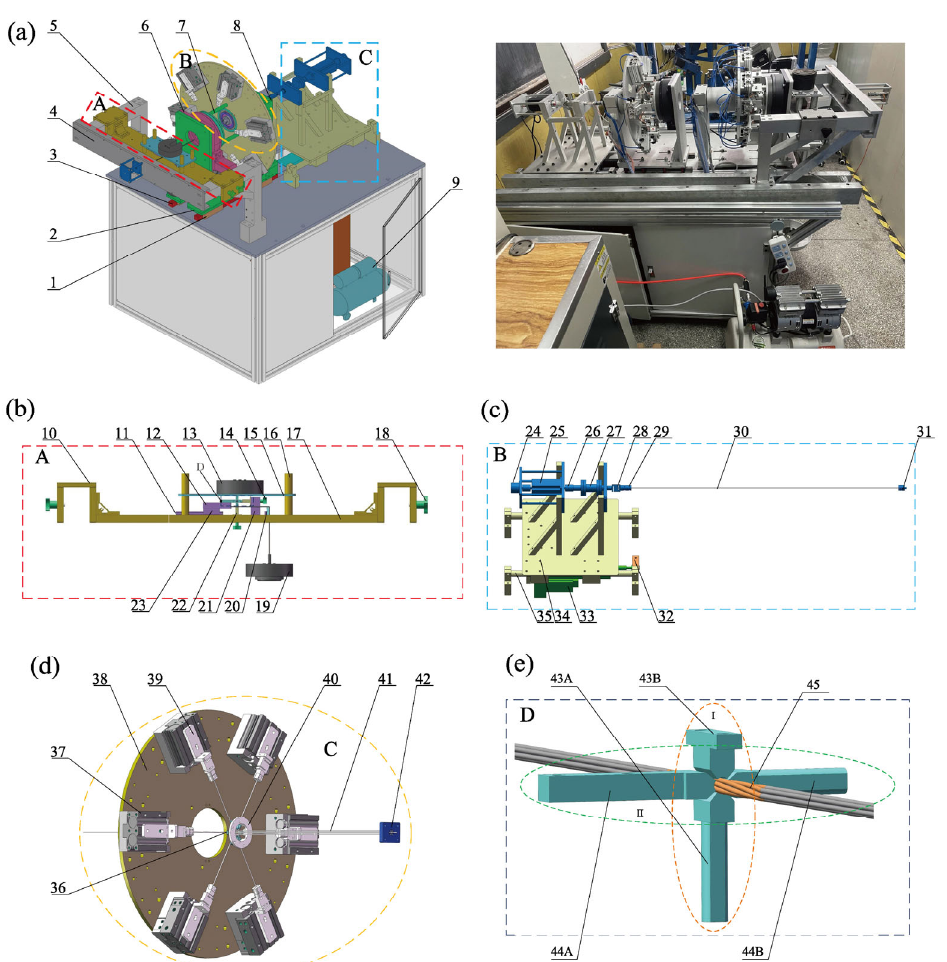
Fig. 2 Structural drawings for the fretting and friction test rig. (a) Whole structure of the test rig, (b) lateral loading device, (c) central wire tension and torsion structure, (d) twisted structure, and (e) circumferential loading structure of rope strands. Note: 1-Slider, 2-Baseplate, 3-Sliding rail, 4-Long baseplate, 5-Cantilever, 6-Electric indexing board, 7-Joint lever, 8-Pneumatic stents, 9-Air pump, 10-U-sheet, 11-Small slider, 12-Continuous blocks, 13-Upper loading block, 14-Ejection knob, 15-Load baseplate, 16-Guide bar, 17-Horizontal loading baseplate, 18-Clamping knob, 19-Lower loading block, 20-Guide pulley, 21-Supporting block, 22-Sleeve, 23-Small slider, 24-Coder, 25-Stepping motor, 26-Coupling, 27-Torque transducer, 28-Tension sensor, 29-Center wire drawing end fixture, 30-Center of steel wire, 31-Center wire fixed end fixture, 32-Fixed connection block, 33-Electric cylinder, 34-Electric cylinder fixing plate, 35-Linear guideway, 36-Guide roller, 37-Air cylinder, 38-Turnplate, 39-Cylinder retaining block, 40-Guide roller fitting seat, 41-Side of the wire, 42-Side steel wire fixing block, 43-Horizontal loading pair, 44-Vertical load pair, and 45-Strand.